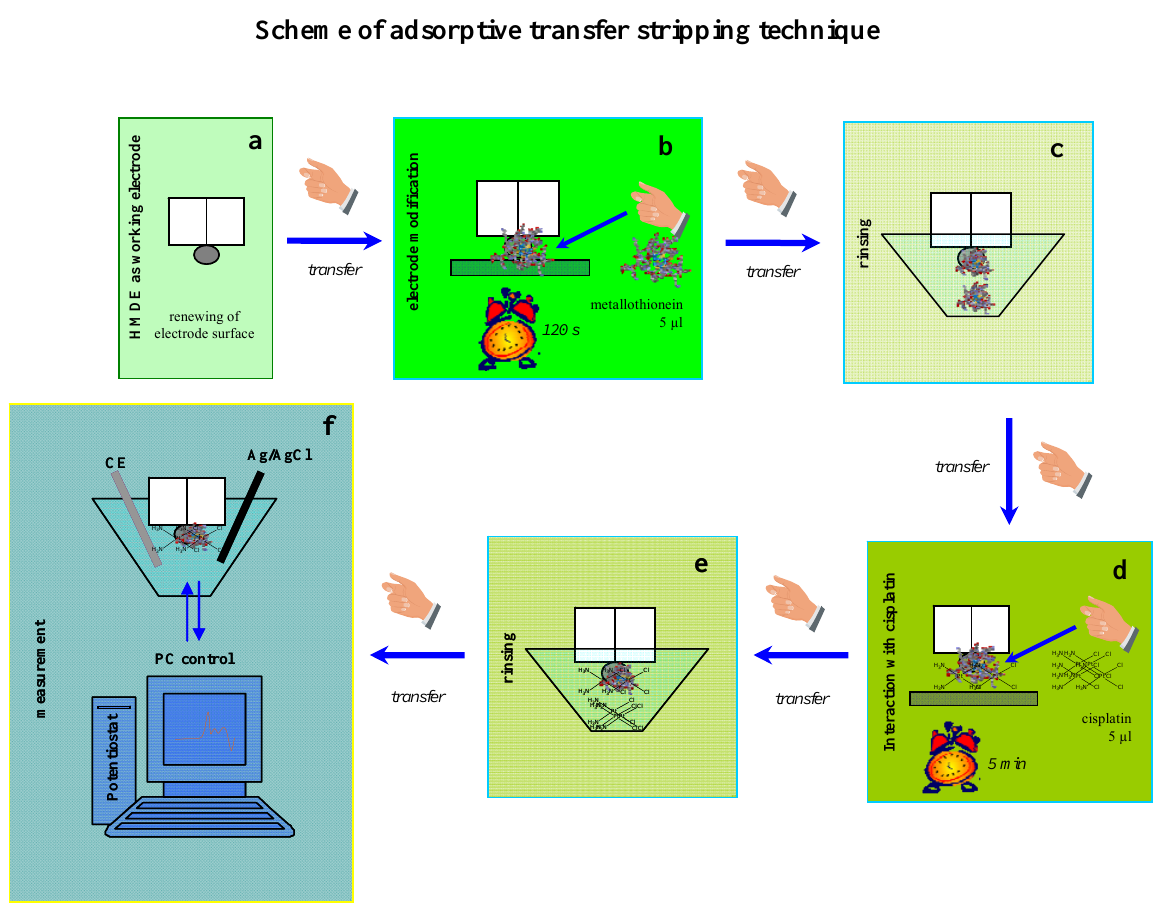
Figure 2. The principle of the adsorptive transfer stripping (AdTS) technique is based on the strong adsorption of the analyte on the electrode surface at the open electrode circuit. (a) A hanging mercury drop electrode surface is renewed. (b) The renewed electrode is immersed in a drop containing a target molecule (metallothionein) to be adsorbed on the surface of this electrode. (c and d) The excess analyte is rinsed from the surface of the working electrode in the buffer and the electrode is transferred to the solution containing a compound with which molecules adsorbed in previous step interacts. After the other rinsing step (e) the adsorbed complex is detected in the presence of supporting electrolyte (f)